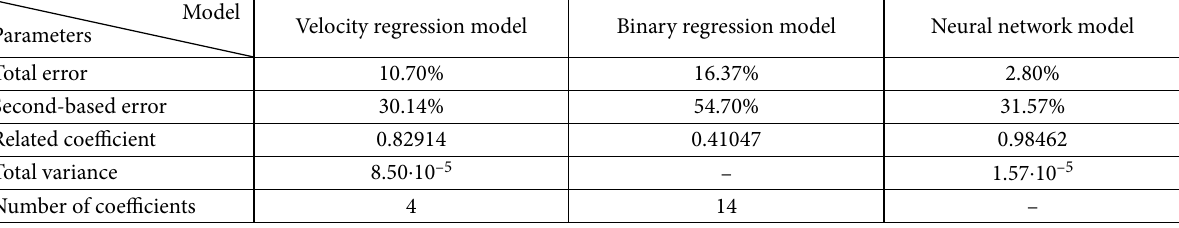
Table 7. HC emission model error analysis